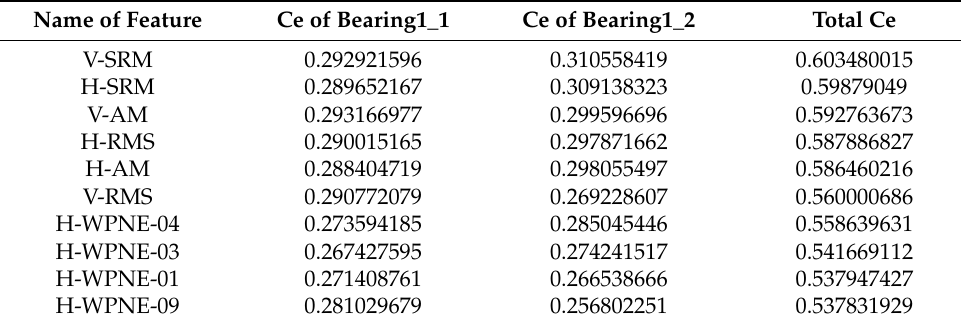
Figure 6. Comprehensive evaluation indicators in descending order for Bearing1_1. Table 6. Total comprehensive evaluation